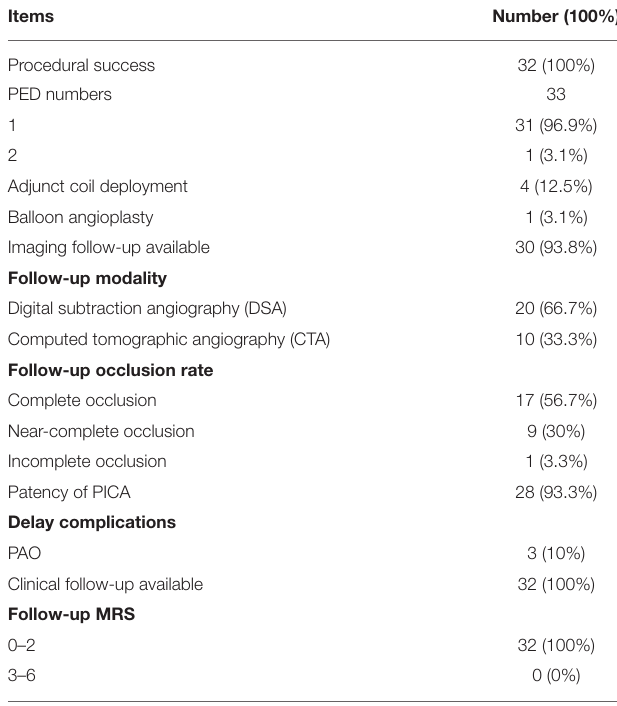
reported 52.7% partial obliteration rate and 10.3% recurrence